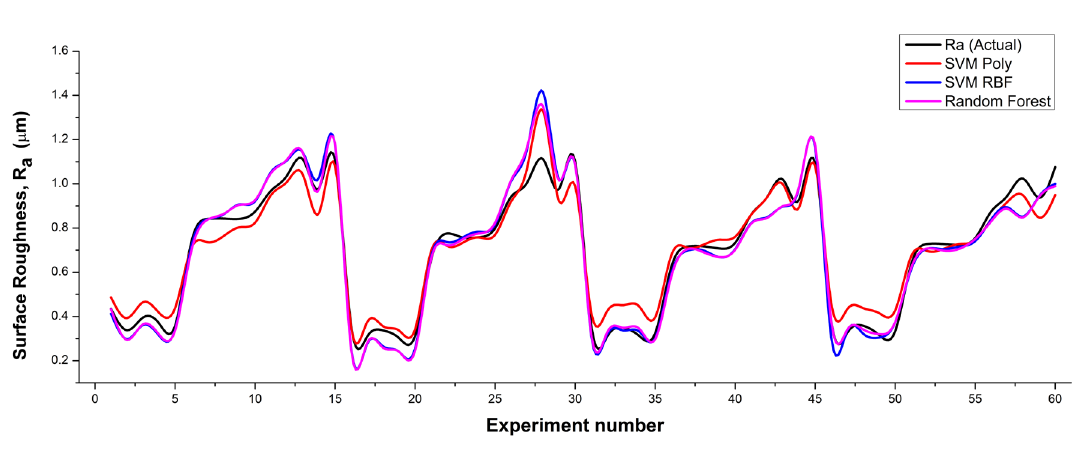
Figure 9. Actual Vs predicted roughness .